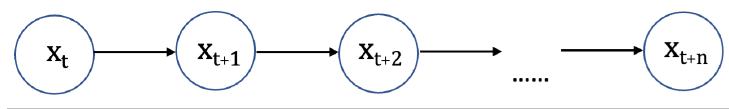
Figure 1. A Generic Markov